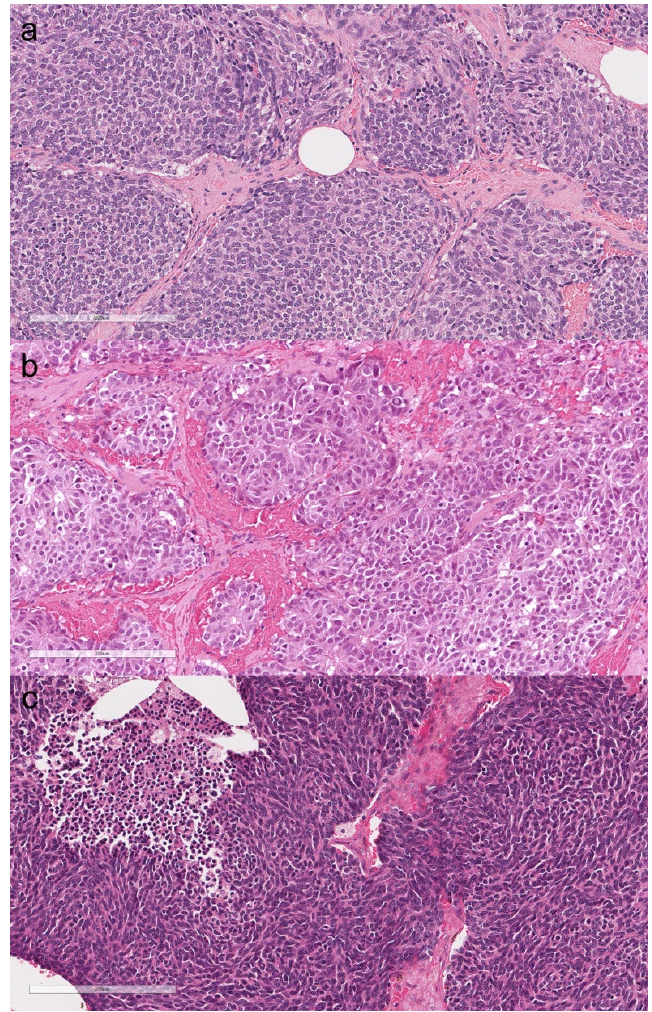
Figure 4. Typical carcinoid. Organoid proliferation of monomorphic neuroendocrine cells without mitotic activity nor necrosis ( a , hematoxylin and eosin, original magnification ×200). Atypical carcinoid. Rosettoid proliferation of neuroendocrine cells showing mild nuclear pleomorphism. Two mitoses are present in the field ( b , hematoxylin and eosin, original magnification ×200). Small cell carcinoma. Proliferation of small cells with necrosis and brisk mitotic activity ( c , hematoxylin and eosin, original magnification ×200).